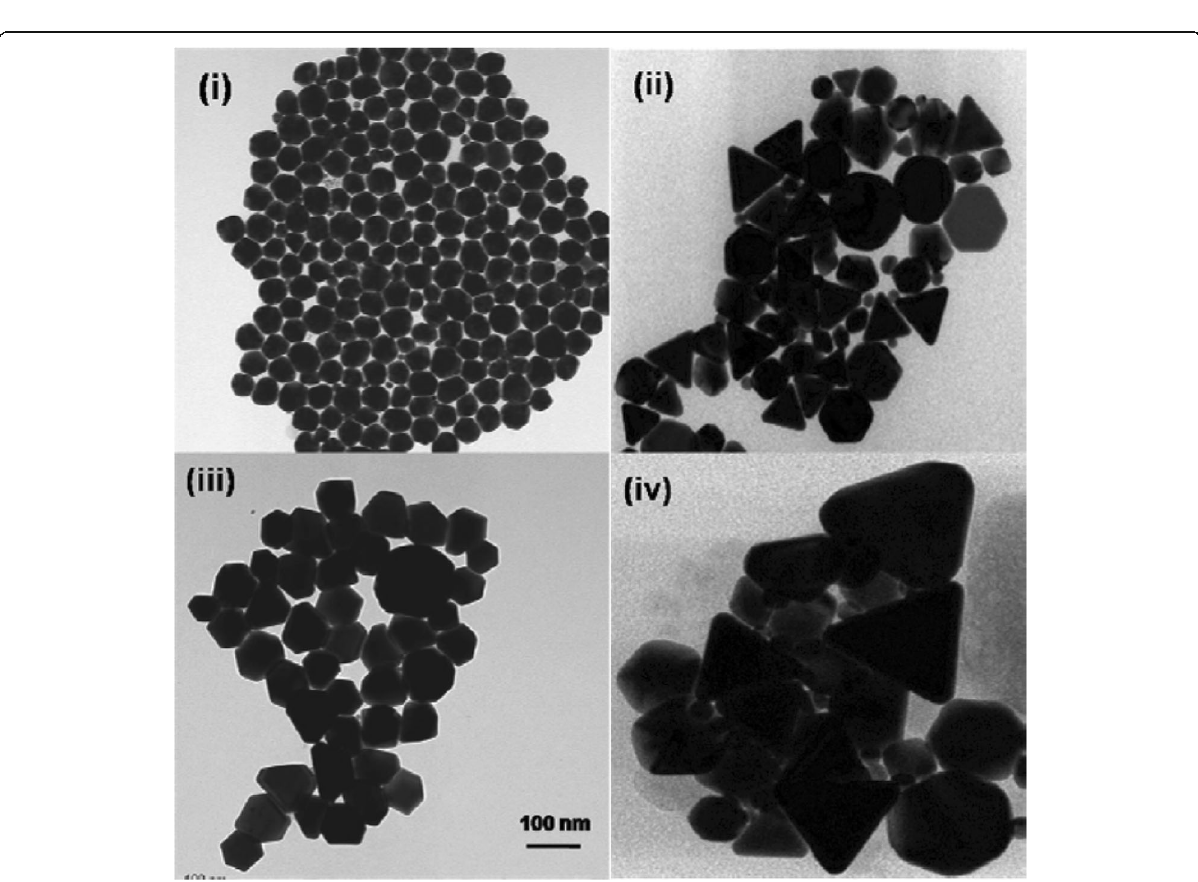
Fig. 4 TEM images of the gold nanoparticles prepared in i 60, ii 70, iii 80, and iv 90% oleic acid [65]. Reprinted with permission from ref.